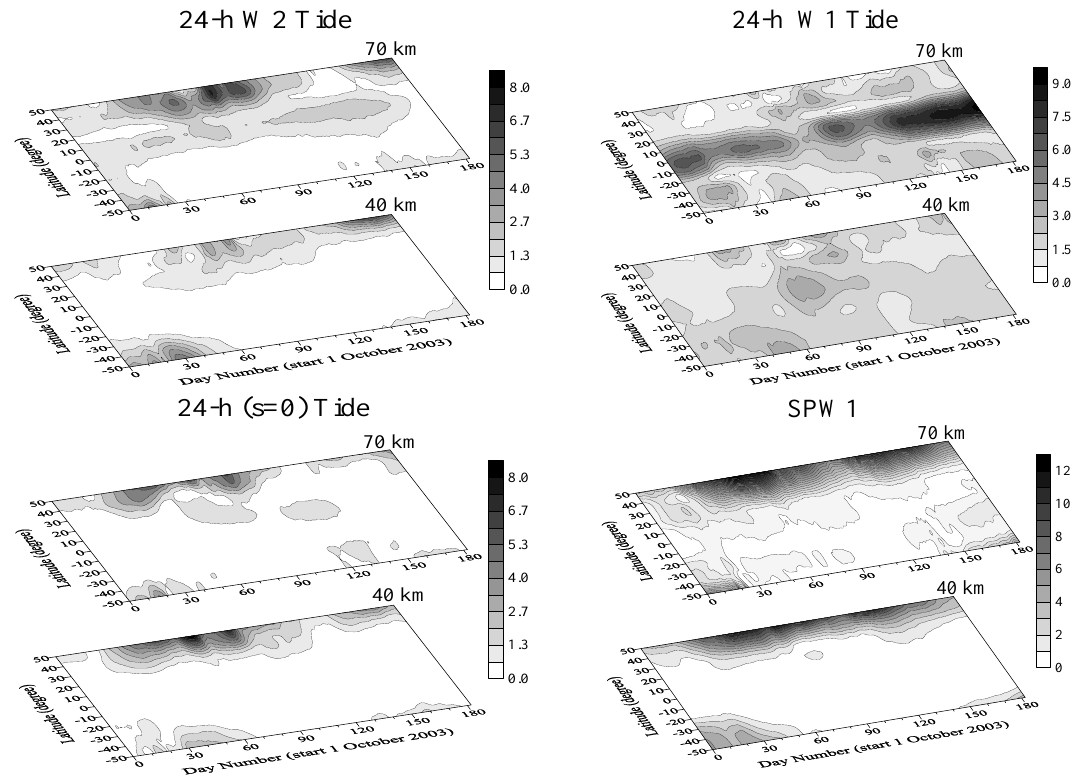
Fig. 7a. Latitude-time cross sections (from 50 ◦ N to 50 ◦ S) of the following amplitudes: nonmigrating W2 tide (upper left plot), nonmigrating s =0 tide (bottom left plot), migrating W1 tide (upper right plot) and SPW1 (bottom right plot) at altitudes of 40km and